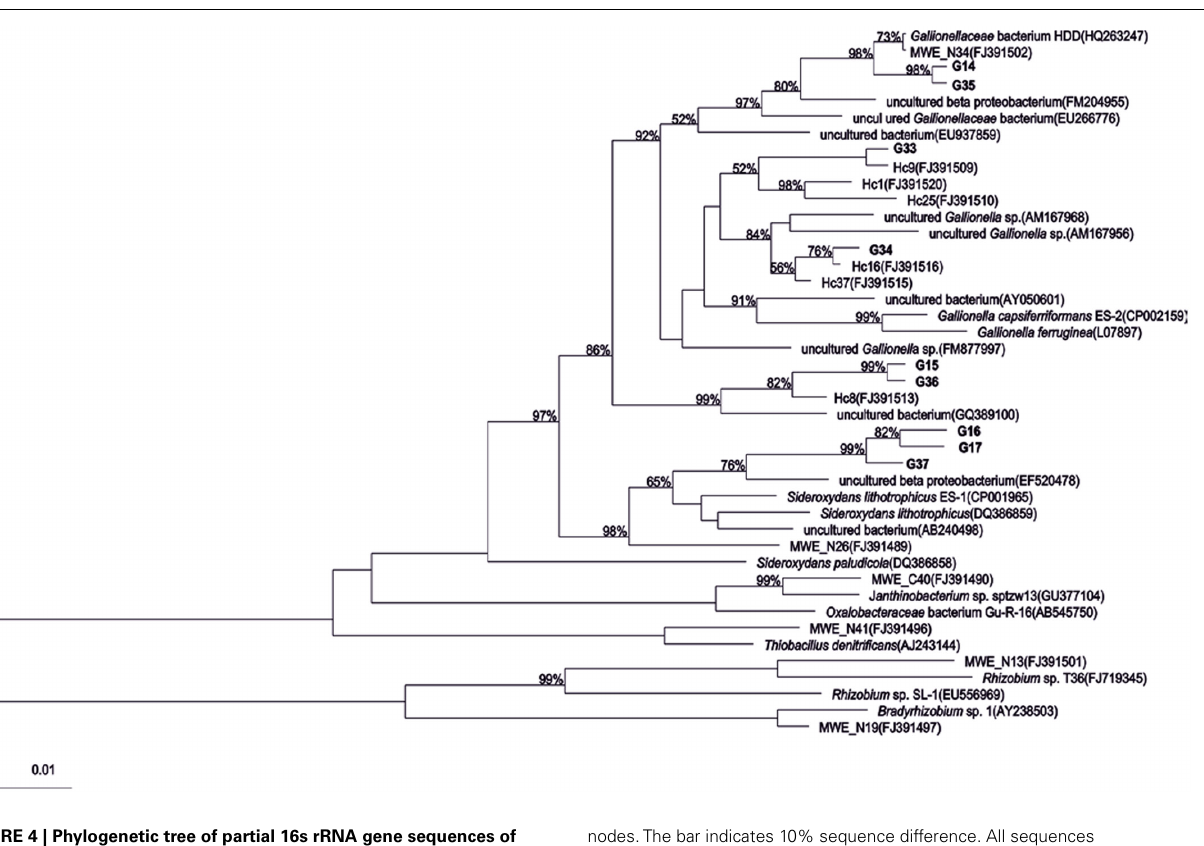
FIGURE 4 | Phylogenetic tree of partial 16s rRNA gene sequences of DGGE bands (see Figure 2) obtained from different sampling scales. Bootstrap values based on 1000 replicate trees are shown near the